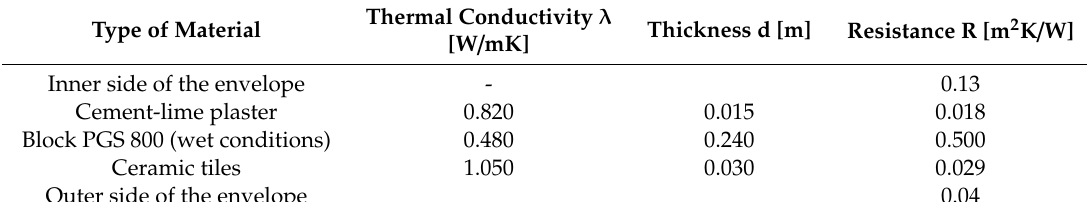
Table 1. Summary of thermal resistance for the gable wall (with mosaic)—the existing state.